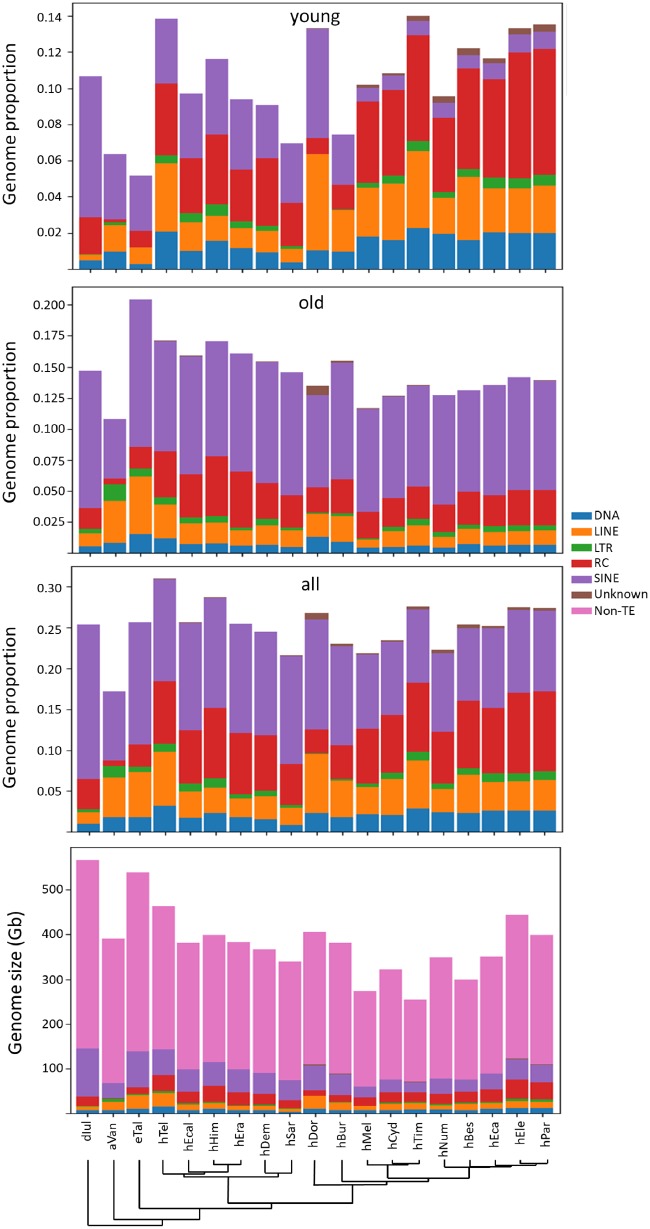
—Stacked bar plots of TE proportions categorized as “old,” “young,” and “all” in each species examined. The combined plot at the bottom represents all data in the context of genome size. Species and their phylogenetic relationships (fig. 1) are depicted on the x axis. Abbreviations are as described in supplementary table 1, Supplementary Material online. Briefly, the first letter indicates genus, and the following three (or four) letters, except in the cases of Heliconius hecale and H. hecalesia, indicate species as listed in figure 1. Values on the y axis are genome proportions calculated as described in the text or total bp representation.